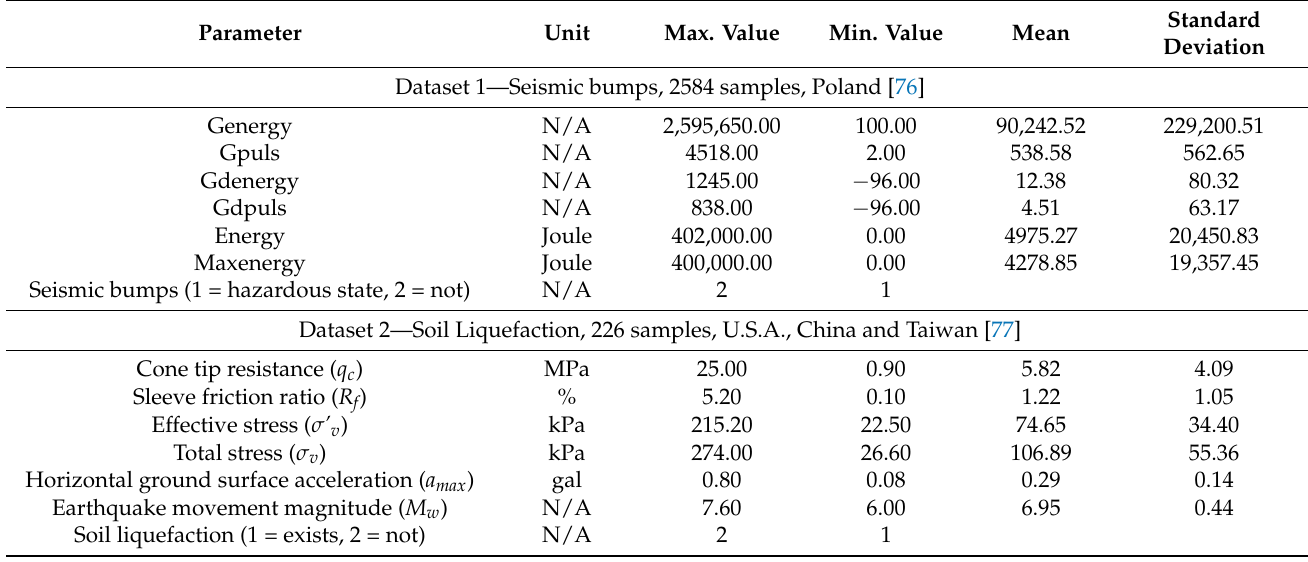
Table 4. Data collection and parameter